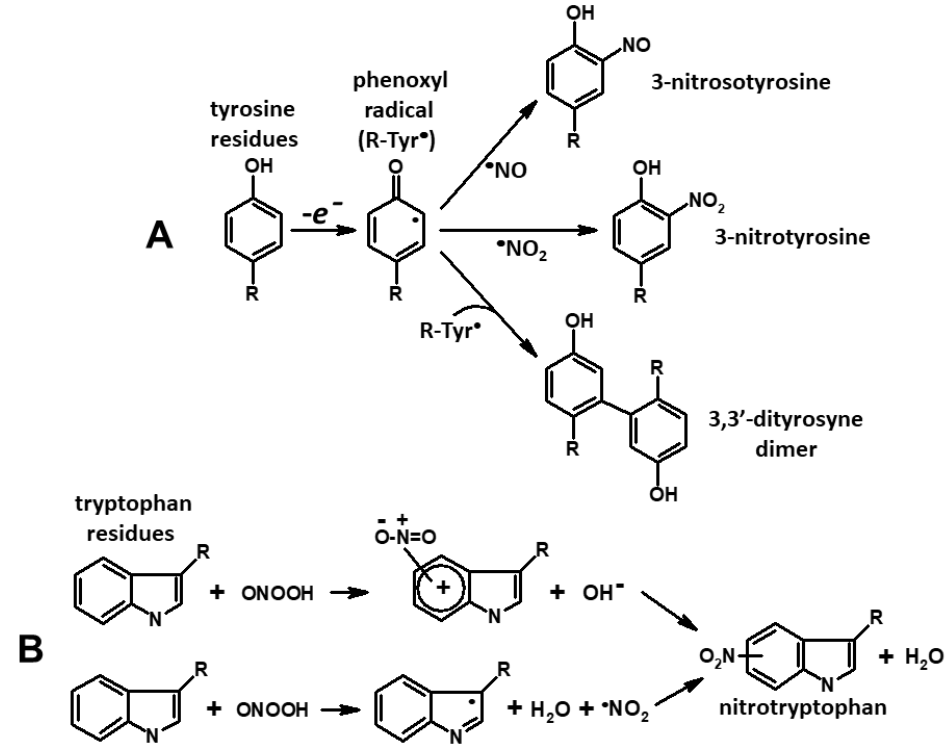
Figure 5. Pathways of nitration of tyrosine ( A ) and tryptophan residues ( B ). Scheme A also shows the formation of 3,3’-dityrosine dimer and 3-nitrosotyrosine.